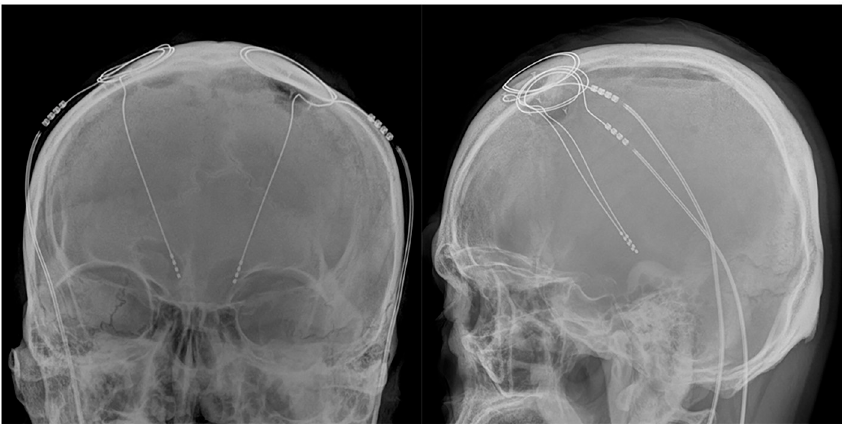
Fig 1. A representative patient’s postoperative intracranial leads on plain radiographs: The leads are obviously bent.